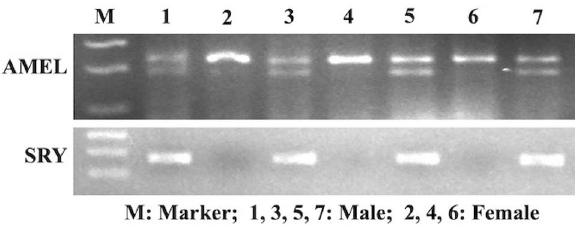
Figure 3. Expression of AMEL and SRY in genomic DNA of ovine